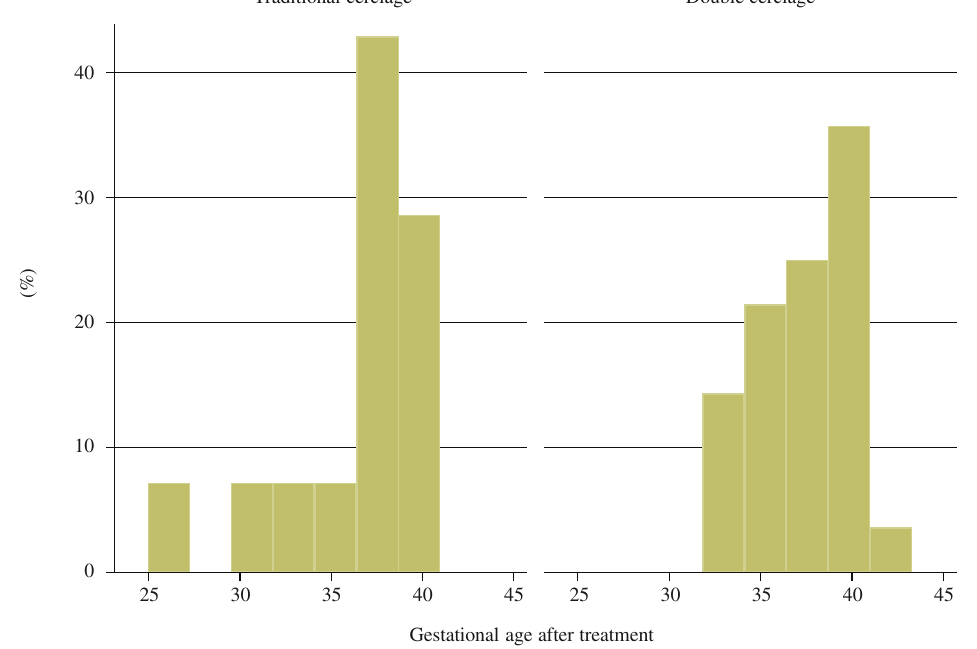
FIGURE 1: Histogram of gestational age after treatment with two treatment